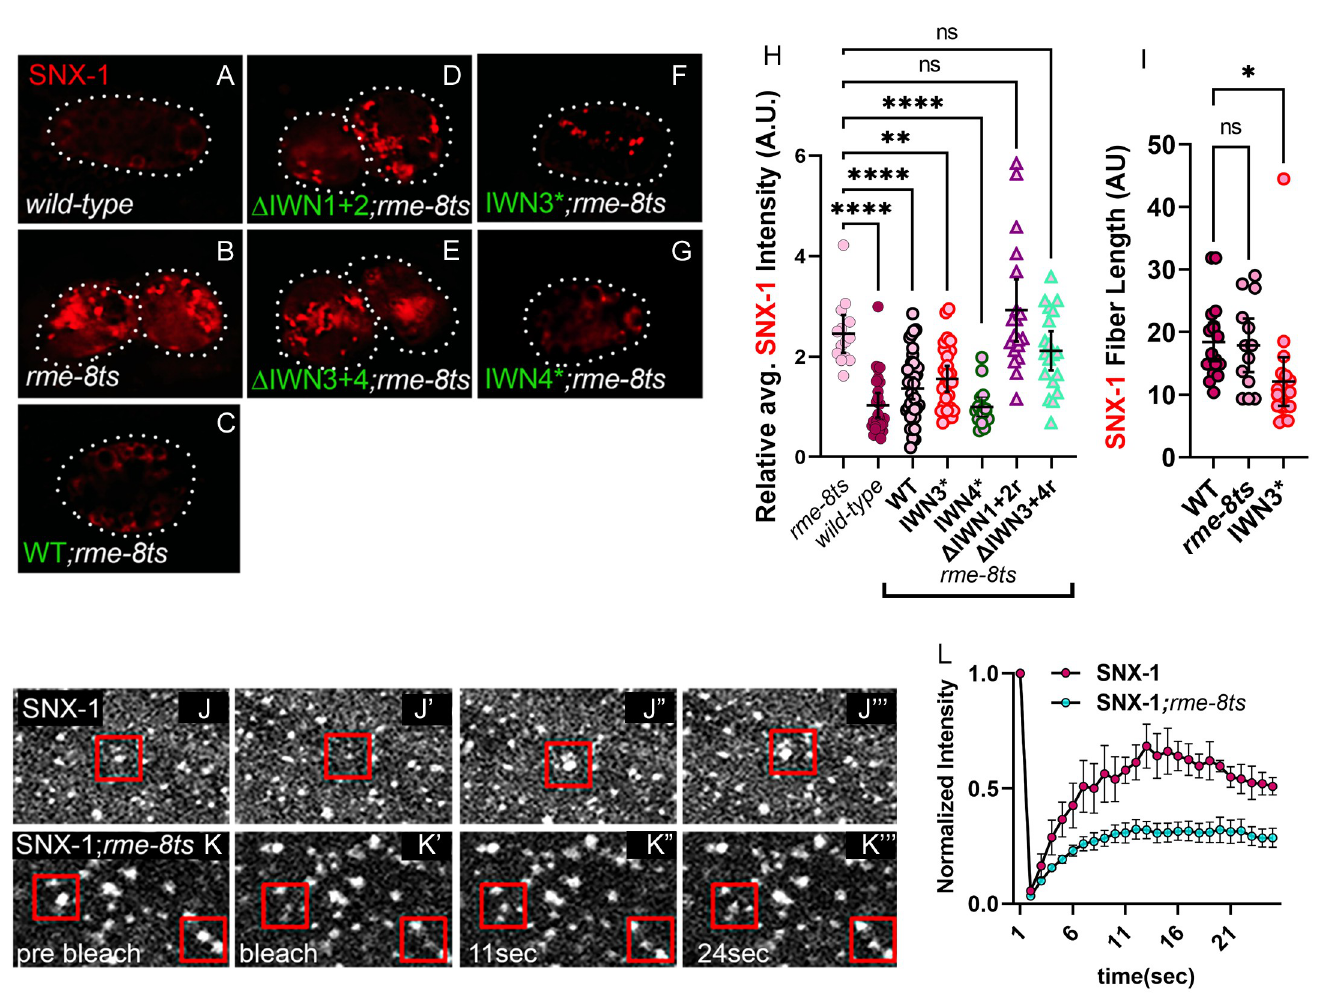
Fig 7. SNX-1 is a target of RME-8 activity. (A-G) Micrograph of tagRFP::SNX-1 co-expressed with GFP::RME-8 WT, N-terminal and C-terminal truncations, as well as the IWN3 � and IWN4 � point mutants in rme-8ts animals. (H) Quantification of tagRFP::SNX-1 average intensity displayed in A-G. (I) Quantification of the fiber length tagRFP::SNX-1 microdomains in animals expressing GFP::RME-8, no RME-8 and GFP::IWN3 � in rme-8ts mutant animals. (J-K”‘) FRAP analysis of GFP-SNX-1 positive endosomes expressed in the hypodermis of wild-type and rme-8ts animals. Red squares indicate endosomes that were bleached. (J) Quantification of FRAP analysis